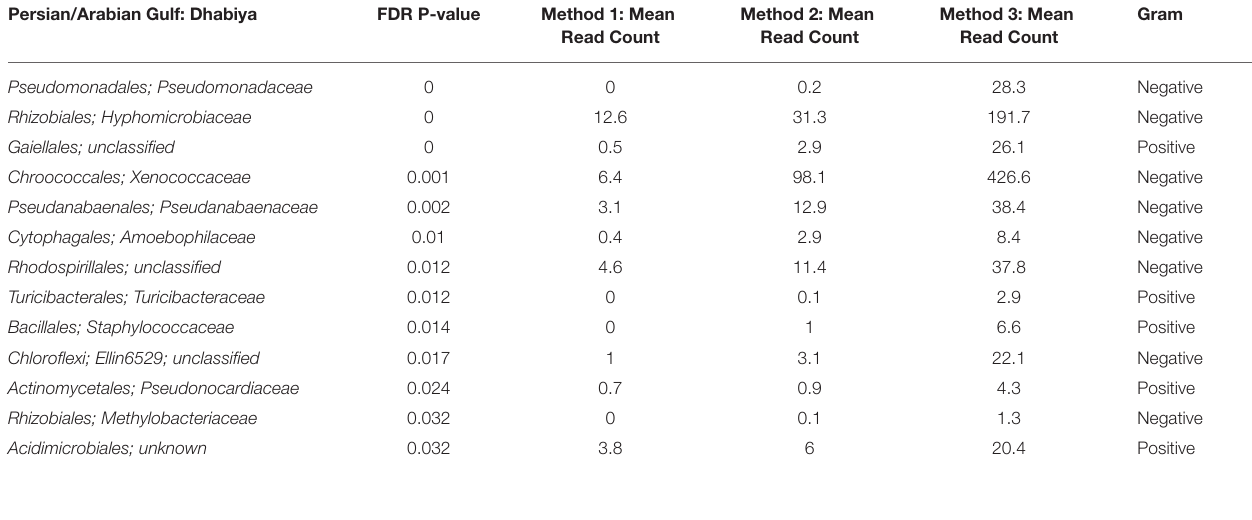
TABLE 1 | All bacterial families that are significantly different between the three methods in the Persian/Arabian Gulf. Persian/Arabian Gulf: